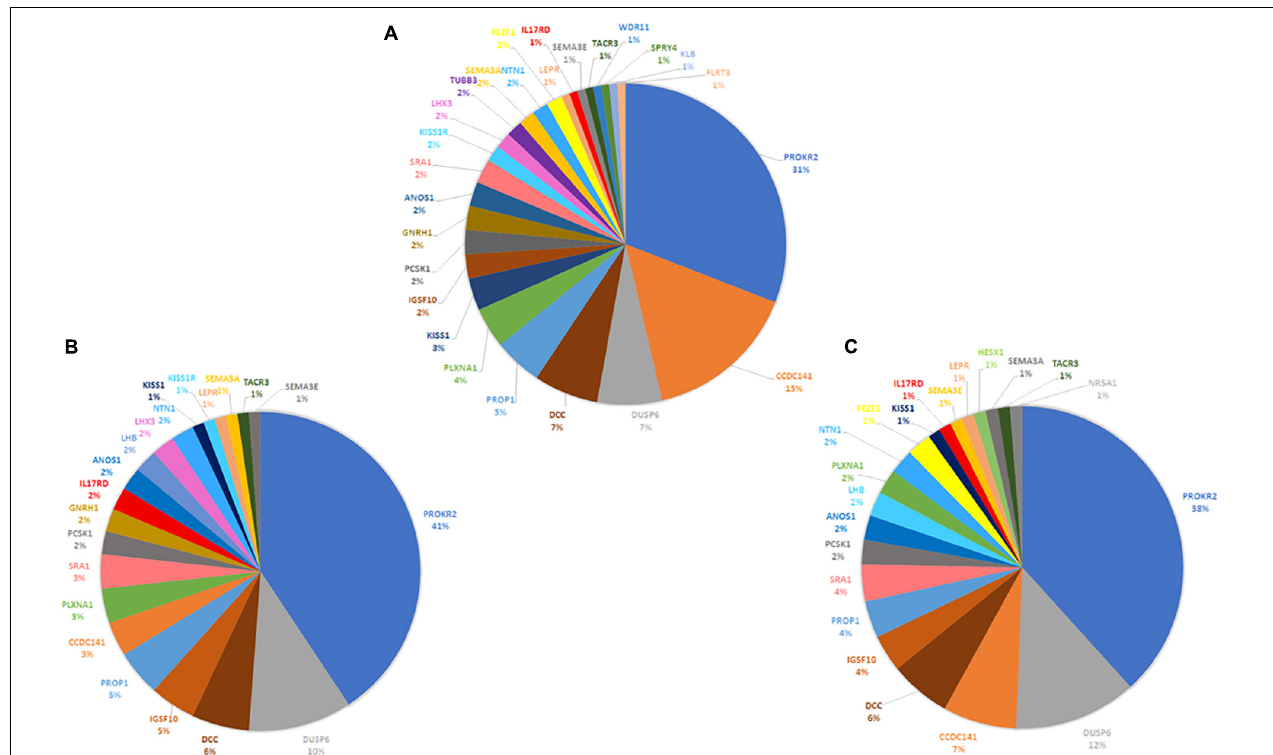
FIGURE 4 | Contribution of CHH-related genes in the digenic inheritance in HH1 family members. Number of disease-causing digenic combinations per gene identified in the index case HH1 (A) in the symptomatic brother HH1F (B) and in the asymptomatic father HH1P (C)